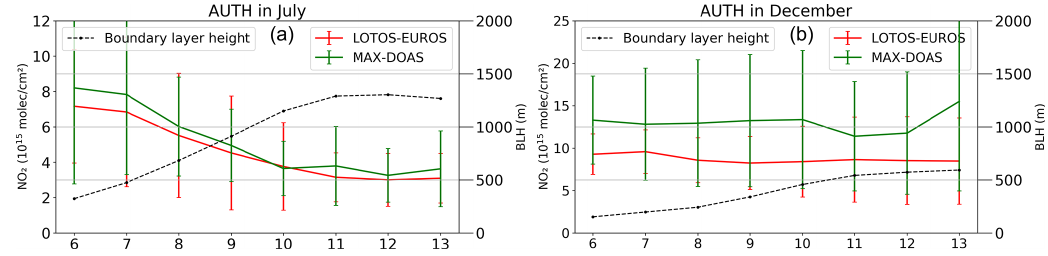
Figure 7. Average diurnal cycle of the MAX-DOAS (green line), LOTOS-EUROS (red line) NO 2 columns and boundary layer height (black dashed line) during July (a) and December (b) in Thessaloniki. The error bars refer to the standard deviations of the averaged measurements and simulations